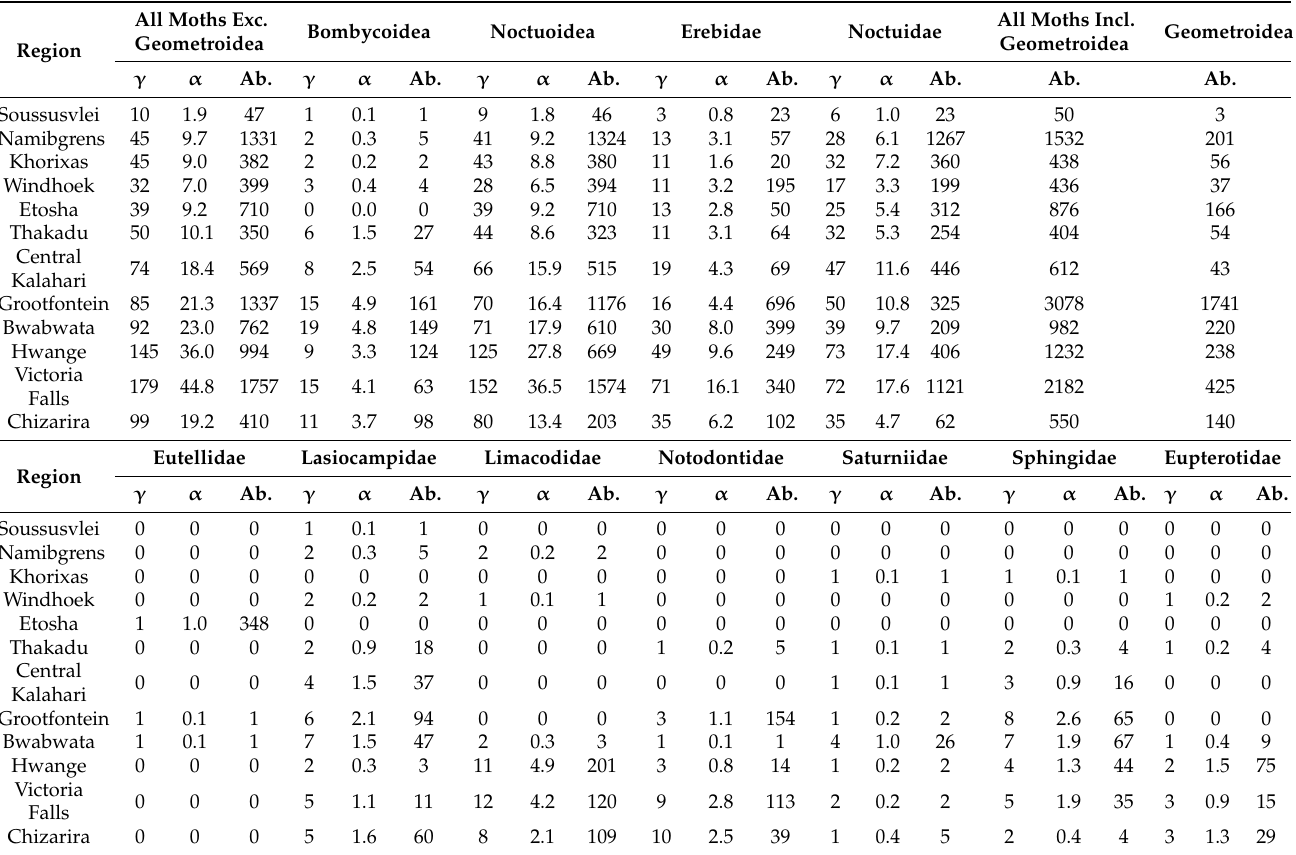
Table 2. Diversity of the focal moth groups at individual regions: gamma diversity ( γ : regional species richness), alpha diversity ( α : mean local species richness), abundance (Ab.: regional number of